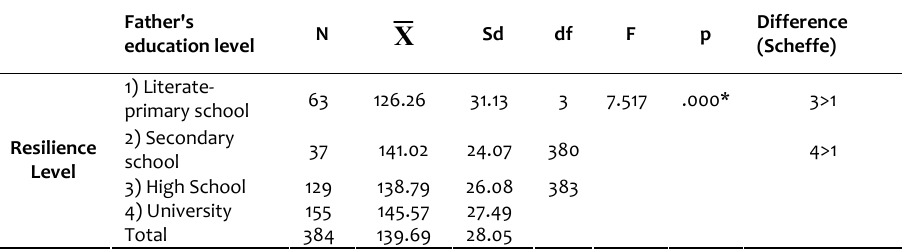
Table 6. Results of ANOVA on Resilience Levels of the 5-Year-Old Preschoolers According to Father's Education Level